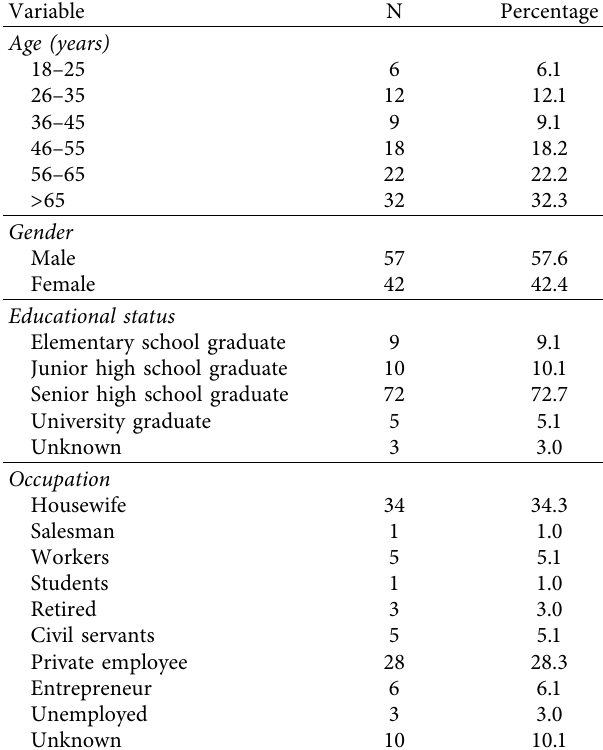
Table 2: The results of culture examination in patients with